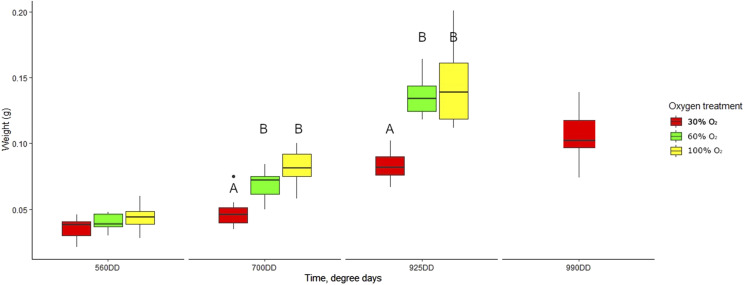
Weight (g) of Atlantic salmon alevins (without yolk sac) sampled for the various oxygen treatments and timepoints throughout the experiment. The 990DD stage of the 30% O2 group was included in the analyses due to slowed development as explained in M&M. Outliers are plotted as individual points. Letters indicate significant weight differences between treatment groups at each point of time (P < 0.05, Kruskal-Wallis test).